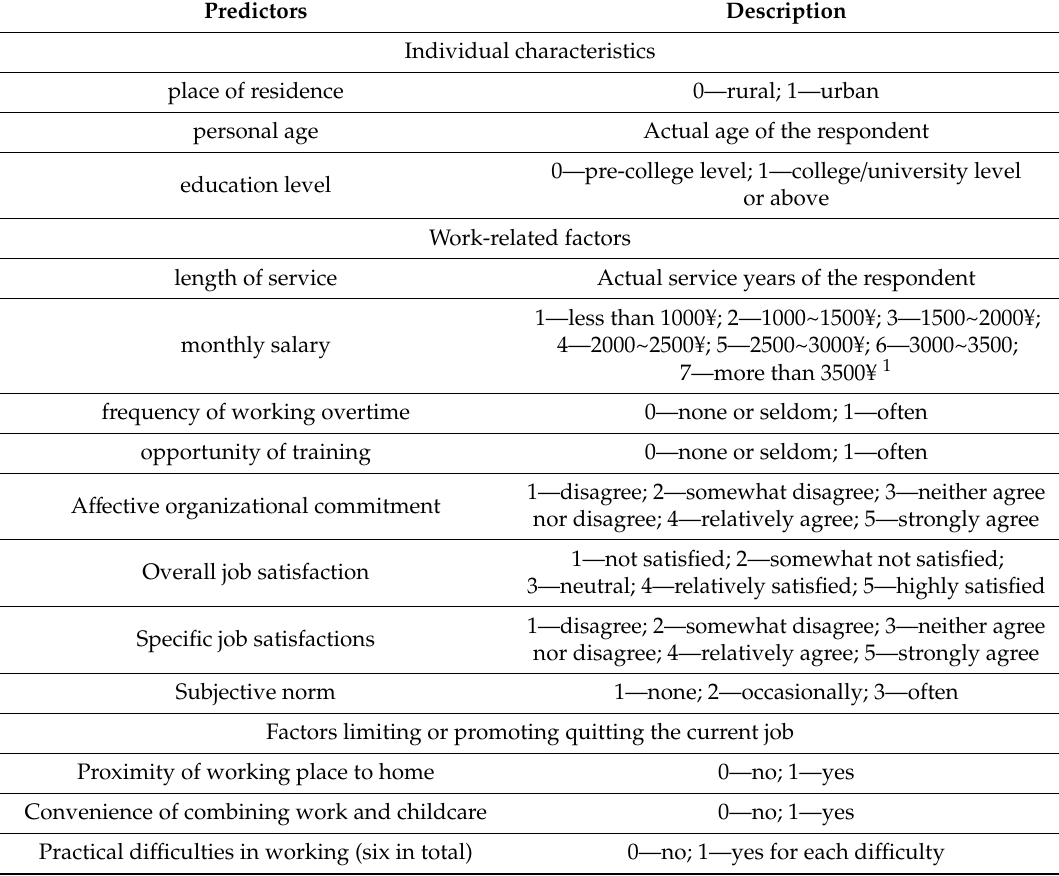
Table A1. The coding of